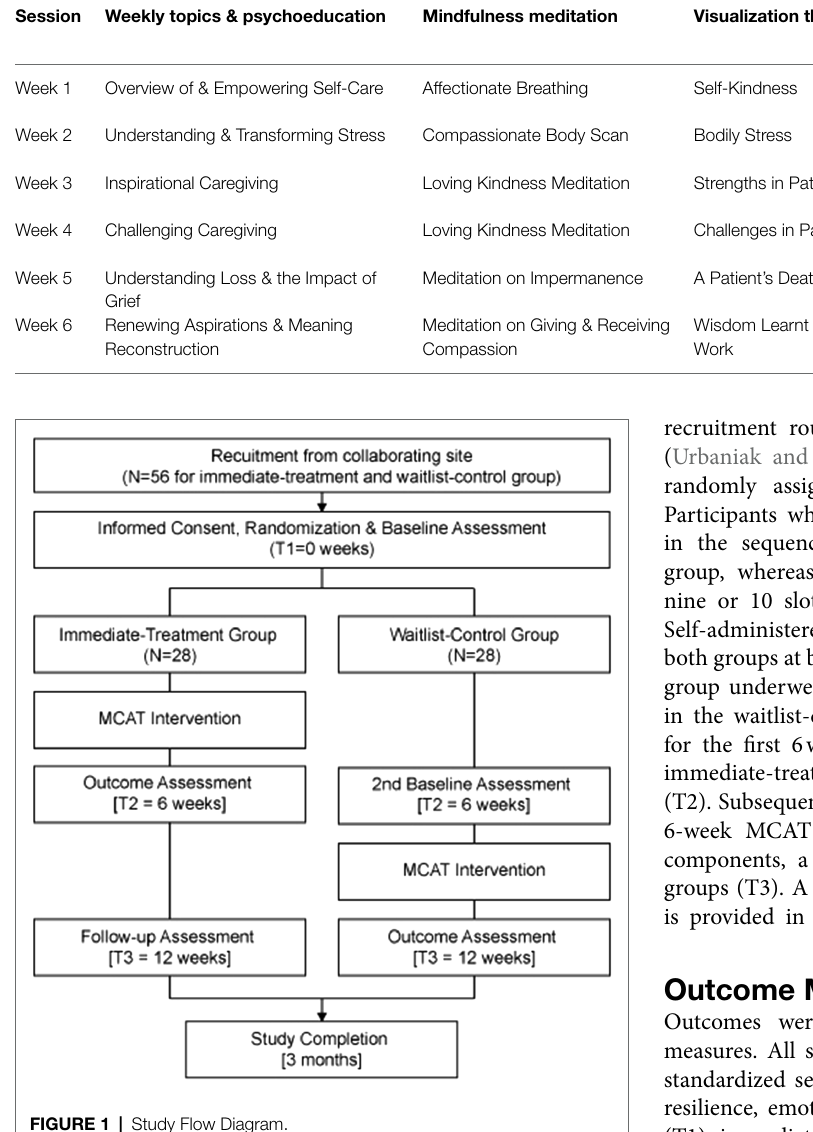
FIGURE 1 | Study Flow